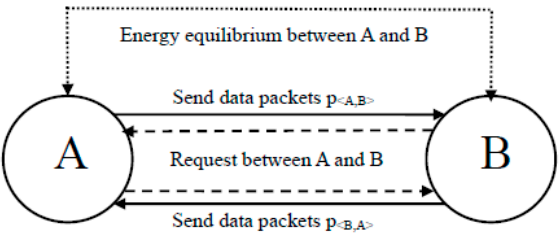
Figure 1. Data packets transmission and energy equilibrium in the epidemic algorithm.